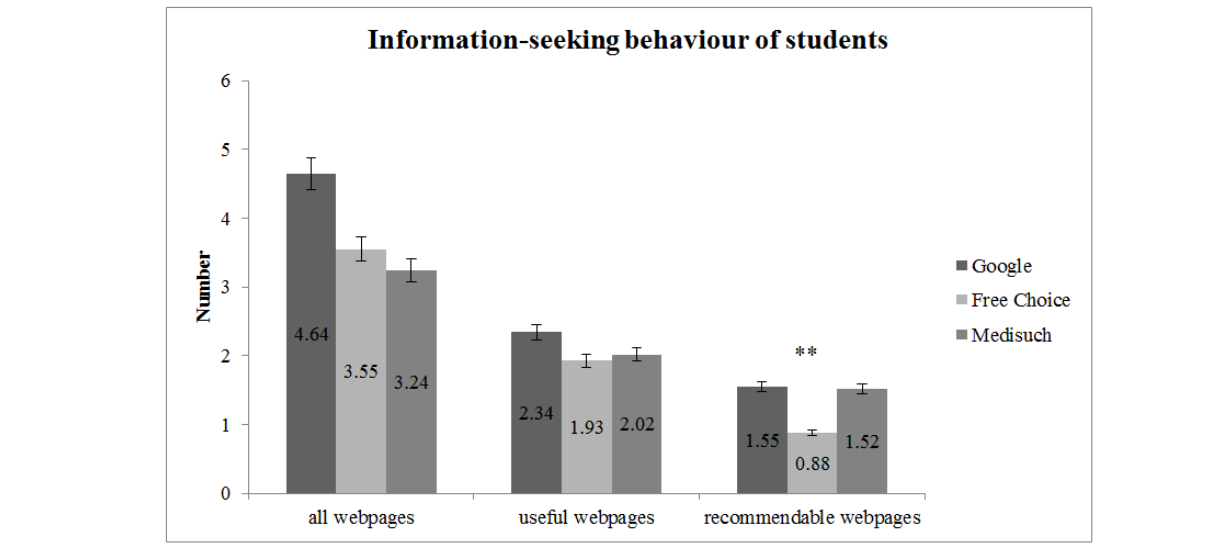
Figure 2. Information-seeking behavior of students regarding the total number of